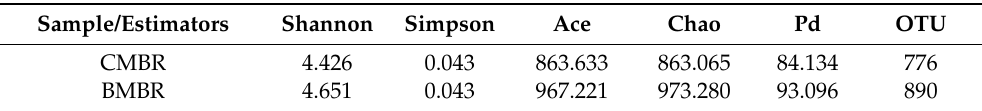
Table 4. Richness and diversity index of the microbial community in conventional MBR (CMBR) and biochar MBR